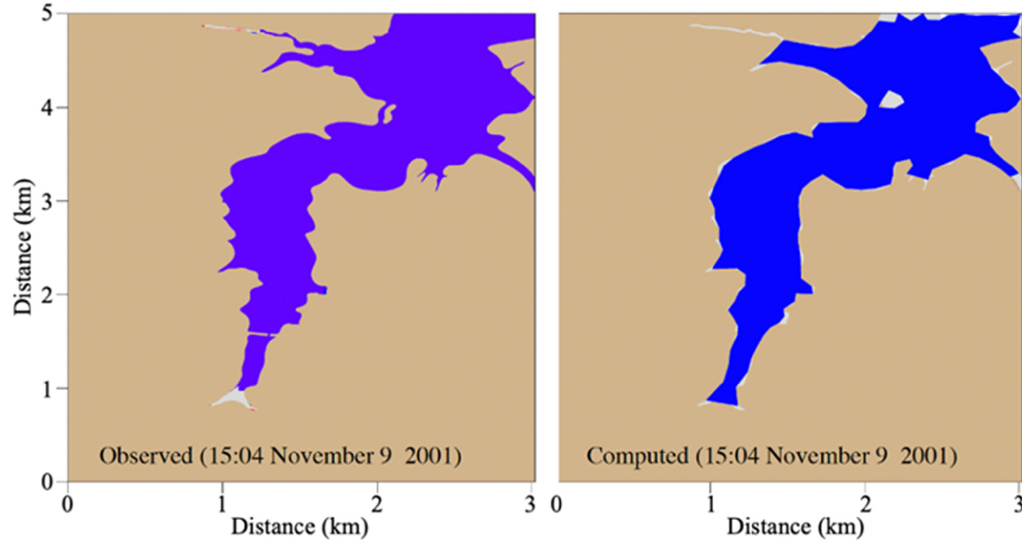
Figure 11. Comparison between model-computed and remote sensing-observed flooded area at high water in the Okatee tidal creek at 3:04 p.m. on 9 November 2001.